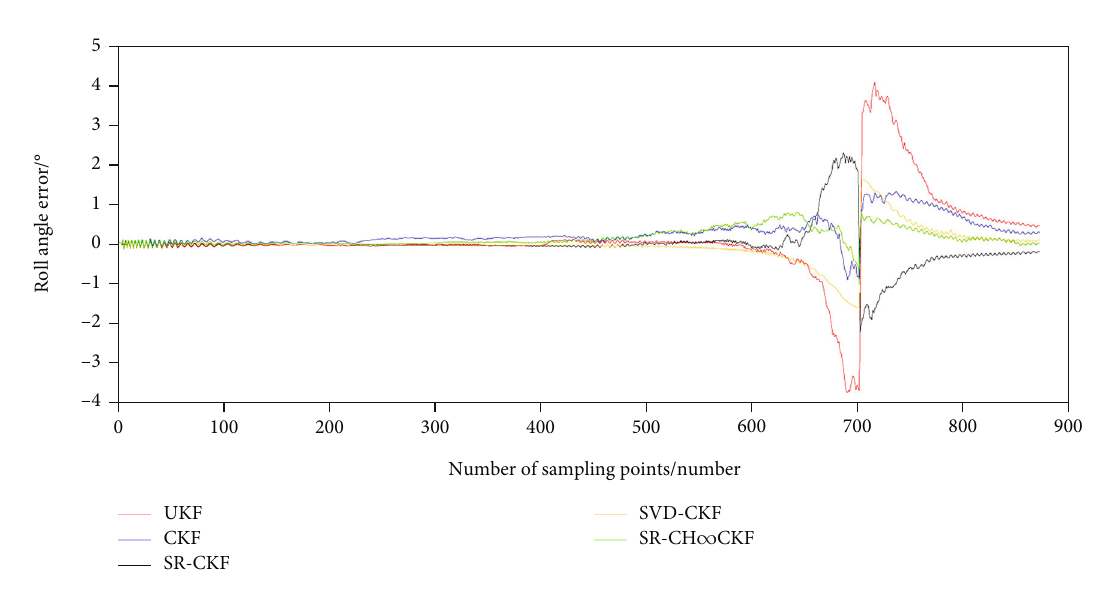
Figure 6: Comparison diagram of yaw angle error.